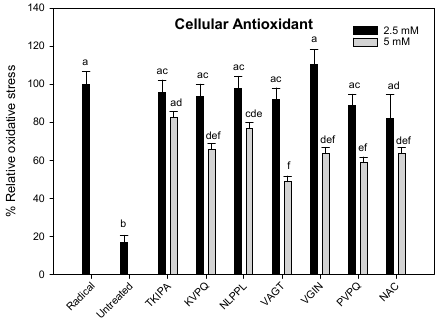
Figure 2. Relative oxidative stress in C2C12 (8 × 10 4 cells/well) after 1 h exposure to synthesized peptides. Radical = cells treated with DMEM + DCFH-DA + ABAP, Untreated = cells treated with DMEM + DCFH-DA, NAC = cells treated with DMEM + N -acetylcysteine + DCFH-DA + ABAP. Experiments were performed in triplicate. Different letters indicate significant difference ( p <